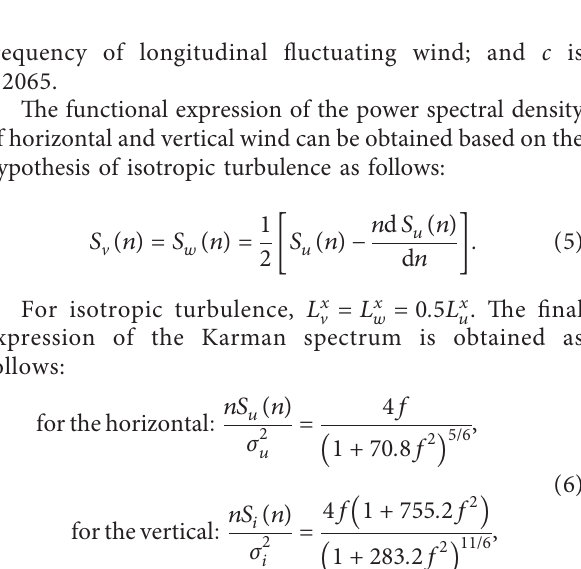
Figure 3: (a) Mean wind speed varying with time. (b) Angle of wind direction varying with